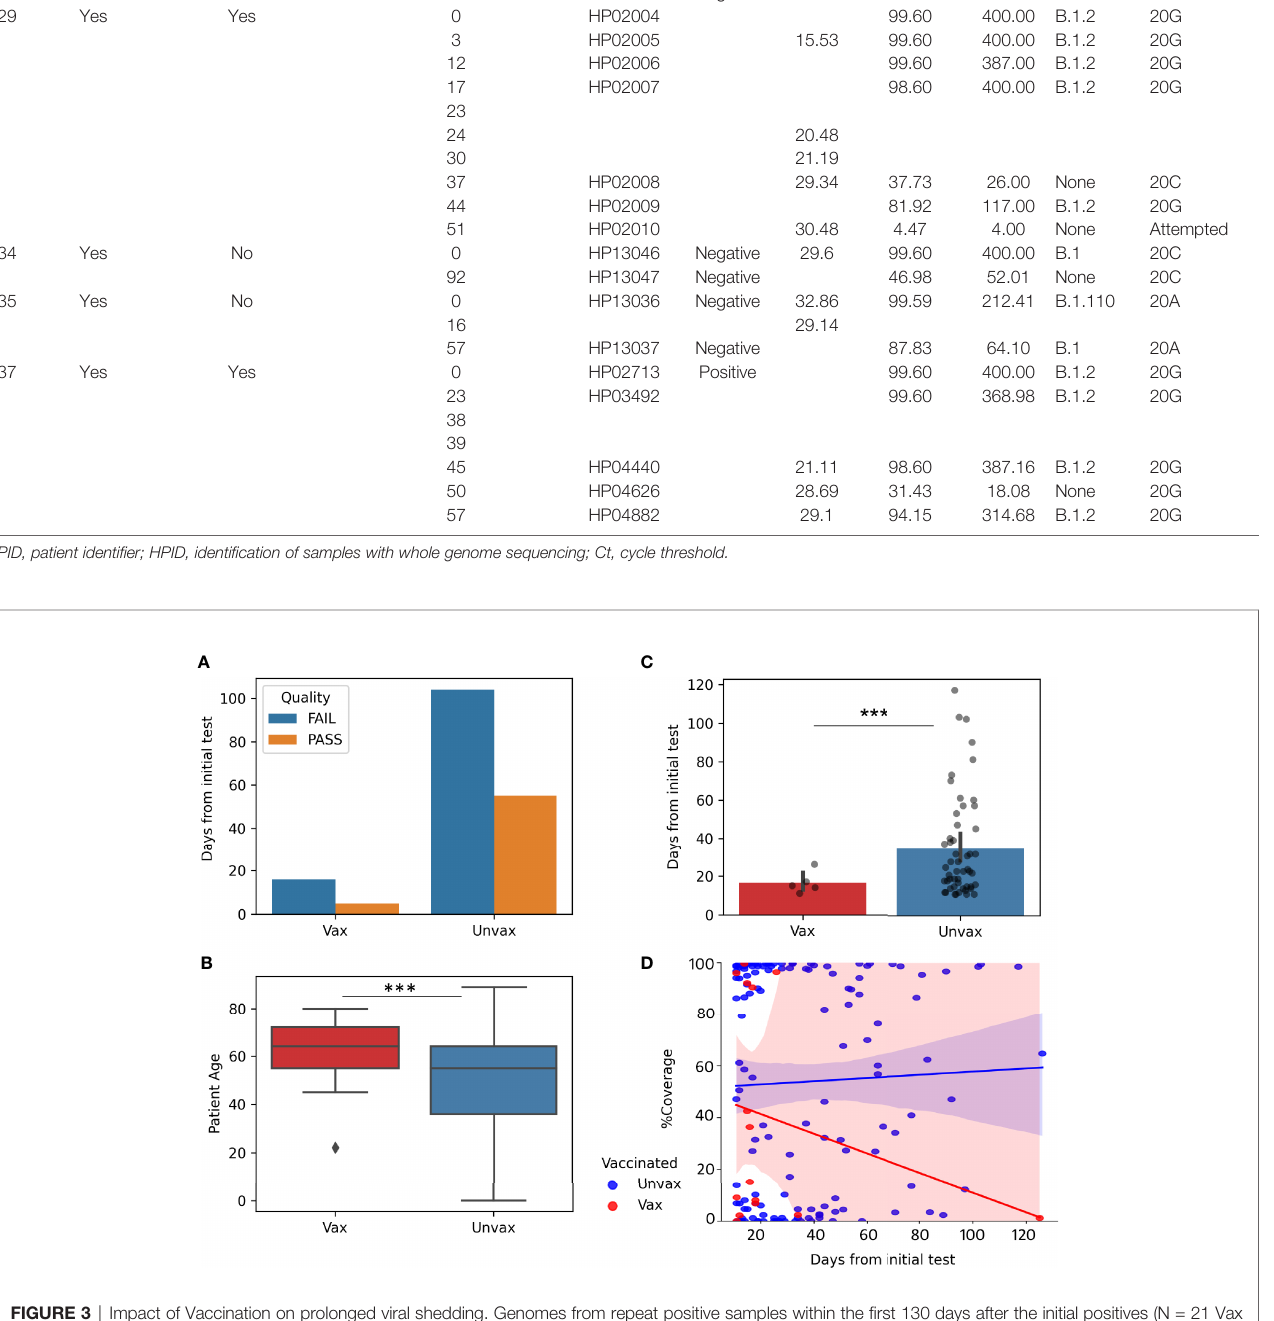
Frontiers in Cellular and Infection Microbiology |